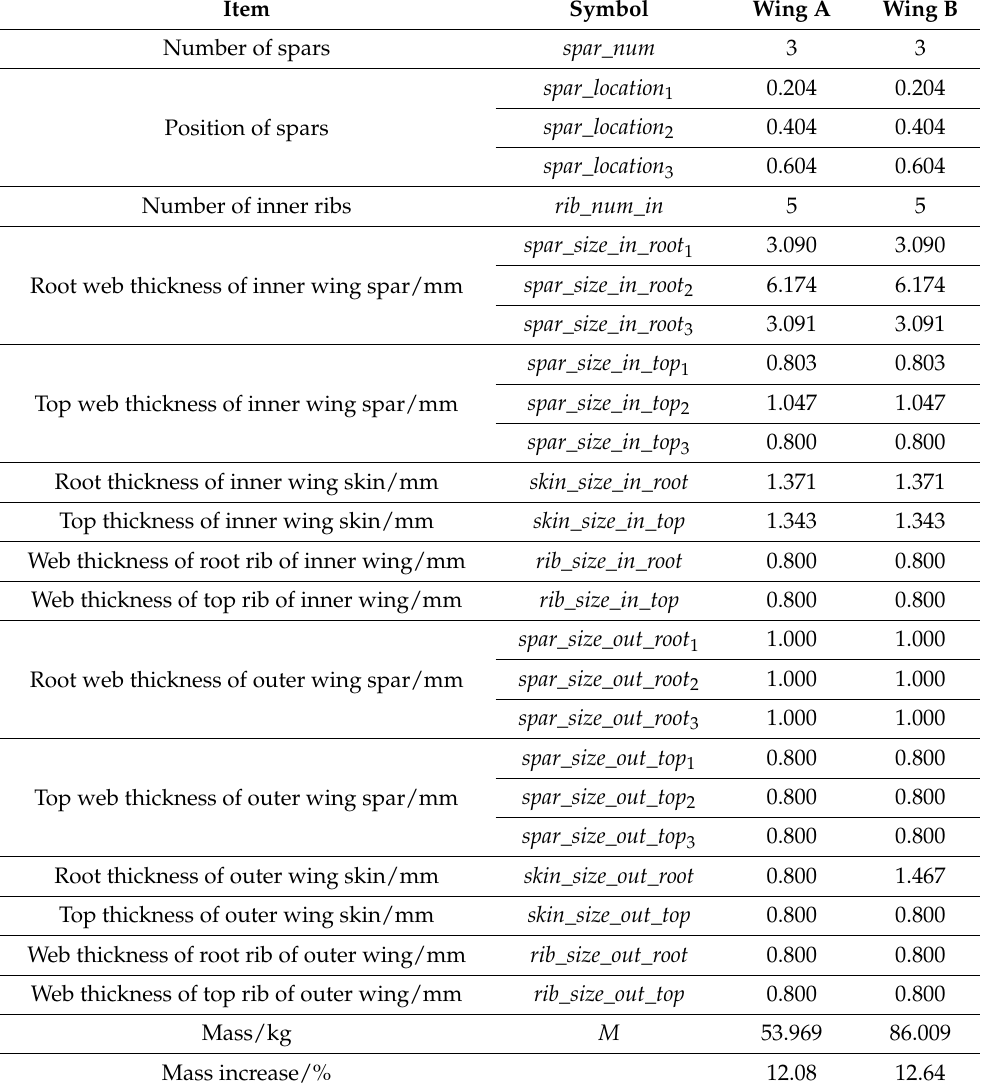
Table 7. General optimization